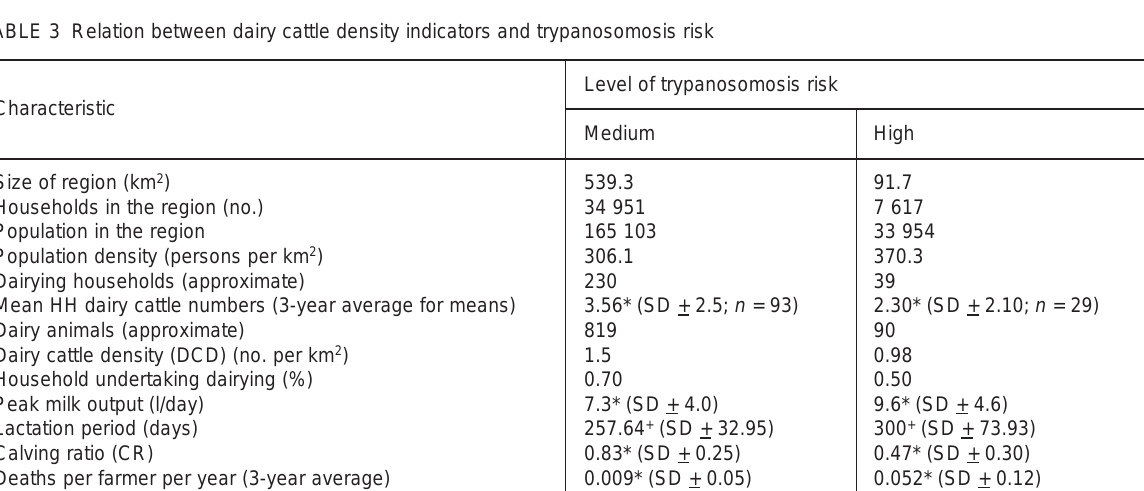
Values with the same superscript are significantly different between groups ( P =